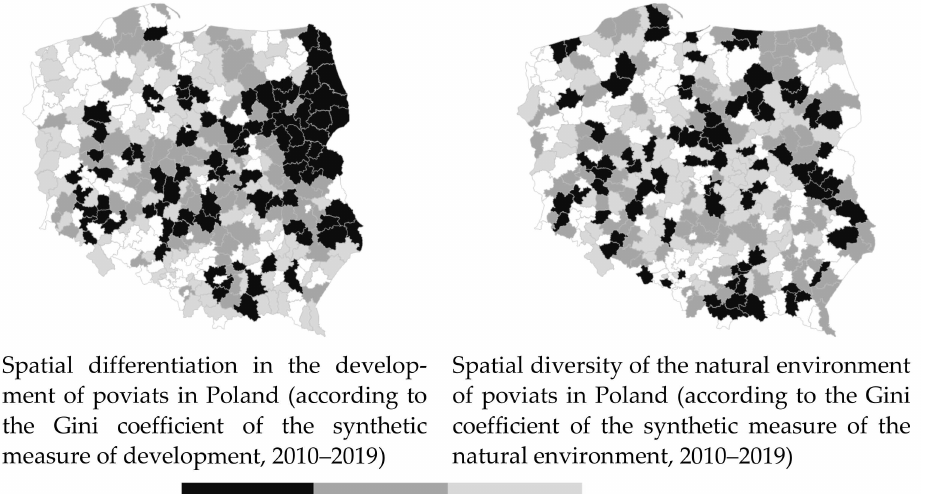
Figure 6. Diversity of counties in Poland according to the measure of concentration in terms of development and natural environment (in 2020–2019). Source: own